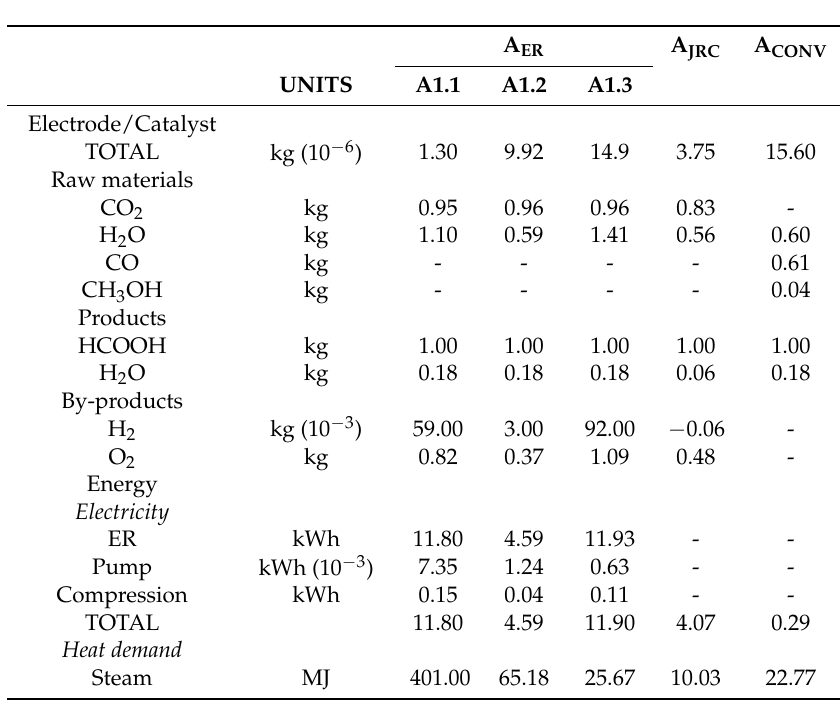
Table 3. LCI for the ER of CO 2 according to the three selected experimental data references (A1.1, A1.2, and A1.3), the conventional commercial process sourced from Ecoinvent [27] (A CONV ), and an alternative CCU process based on the catalytic conversion of CO 2 and H 2 [7] (A JCR ). The functional unit is 1 kg